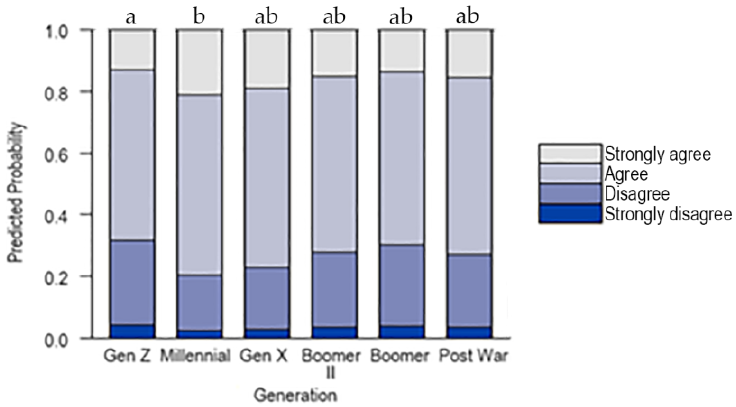
Figure 6. Predictor effect plots for responses to Statement 23 (“Zoo staff provide the animals in their care with a high quality of life”), showing the effect of generation for the python experiment. Results are averaged over levels of other predictor variables. Predictor levels that do not share any letters are significantly different ( p < 0.05) as determined by pairwise comparisons conducted using the Tukey method.